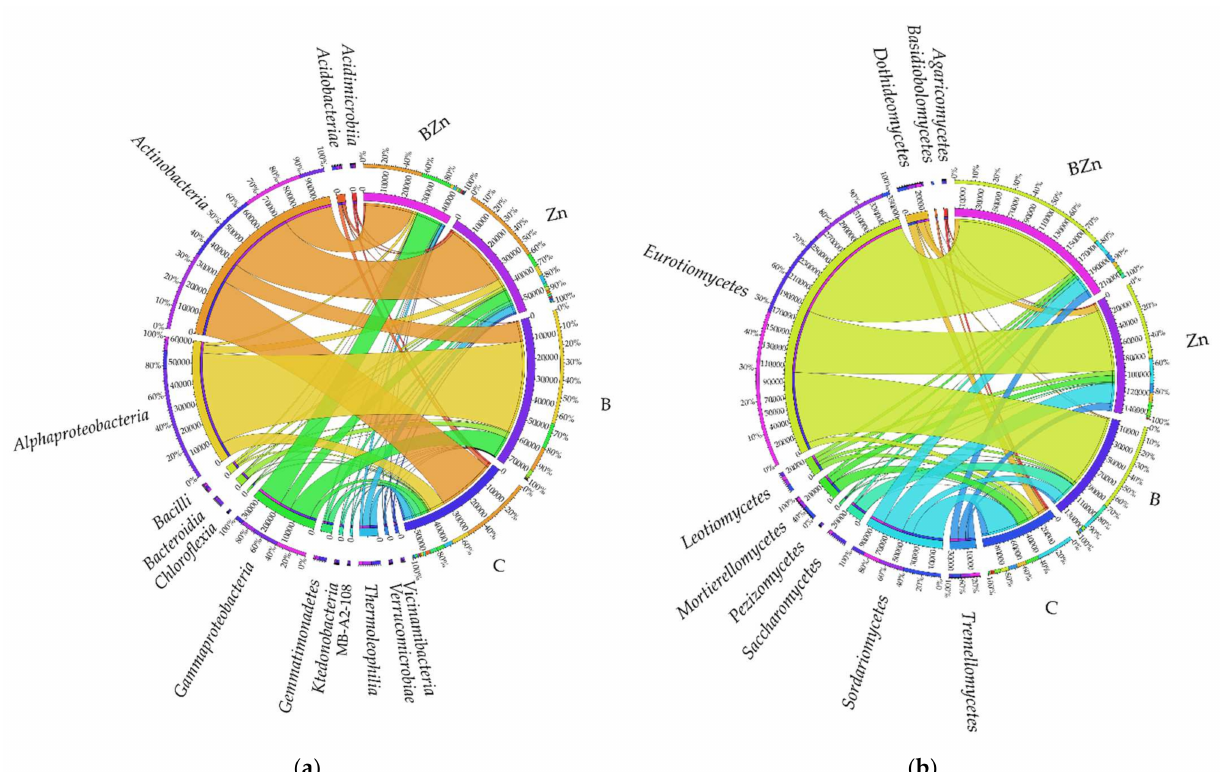
Figure 9. The relative abundance of dominant classes of bacteria ( a ) and fungi ( b ) in soil with a difference between proportions ≥ 1%; C—uncontaminated soil; B—bisphenol A; Zn—ion zinc (Zn 2+